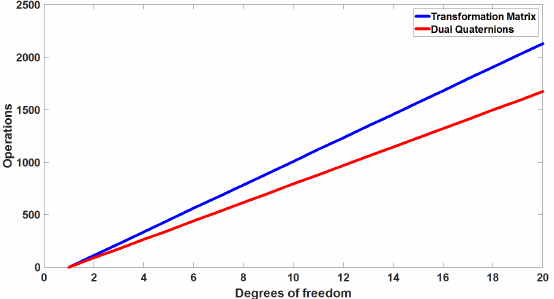
Figure 7. Comparing the number of operations between Denavit–Hartemberg and dual quaternions.